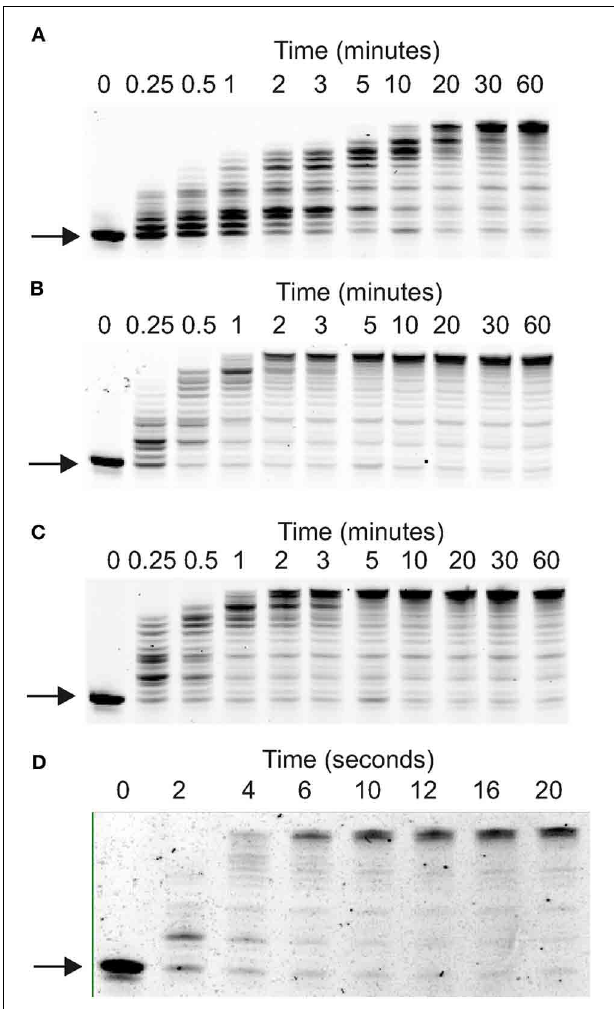
FIGURE 2 | Elongation of Primer-templates by archaeal family-B DNA polymerases. Gel electrophoretic analysis of primer strand extension observed with: (A) Pfu-Pol wild type; (B) Pfu-Pol M247R/L381R; (C) Pfu-Pol L381R/K501R; (D) Tkod-Pol. The primer-template used was: 5 (cid:2) -GGGGATCC TCTAGAGTCGACCTGC 3 (cid:2) -CCCCTAGGAGATCTCAGCTGGACGACCGTTCGTT CGAACAGAGG. The primer was labeled at its 5 (cid:2) -terminus with either cyanine 5 (used with wild type Pfu-Pol and the double mutants) or fluorescein (used with